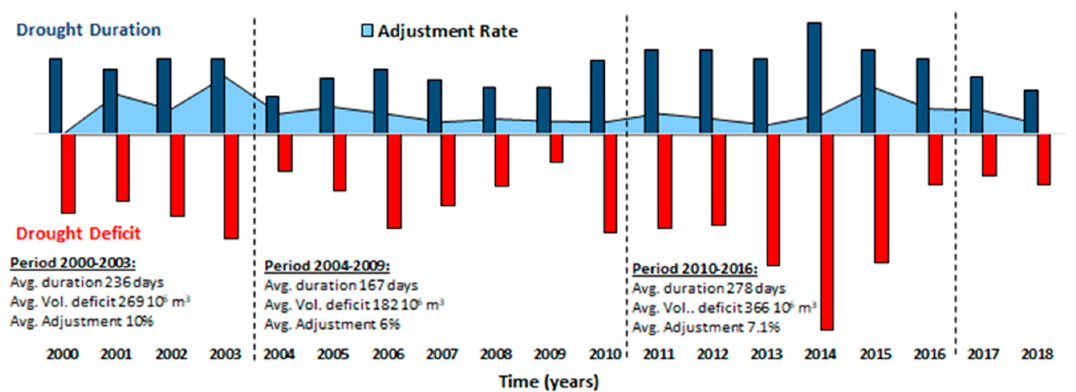
Figure 4. Empirical relationship between Cantareira system drought duration (blue bars, in days), derived from monthly average discharge analysis, drought deficit (red bars, in 10 6 m 3 ), and annual price adjustment rates under variable hydrological conditions (in percentages).